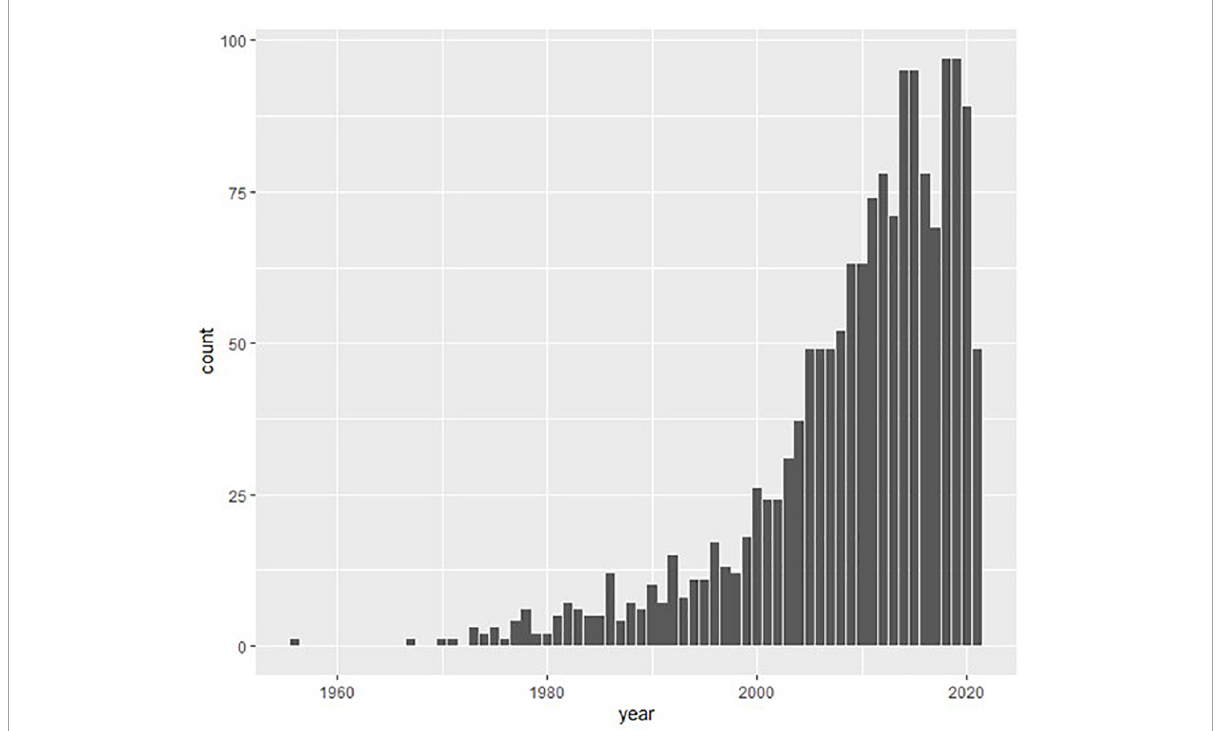
FIGURE1 Number of publications per year with “explained variance,” coefficient of determination” or “R-squared” in the abstract in PsychINFO